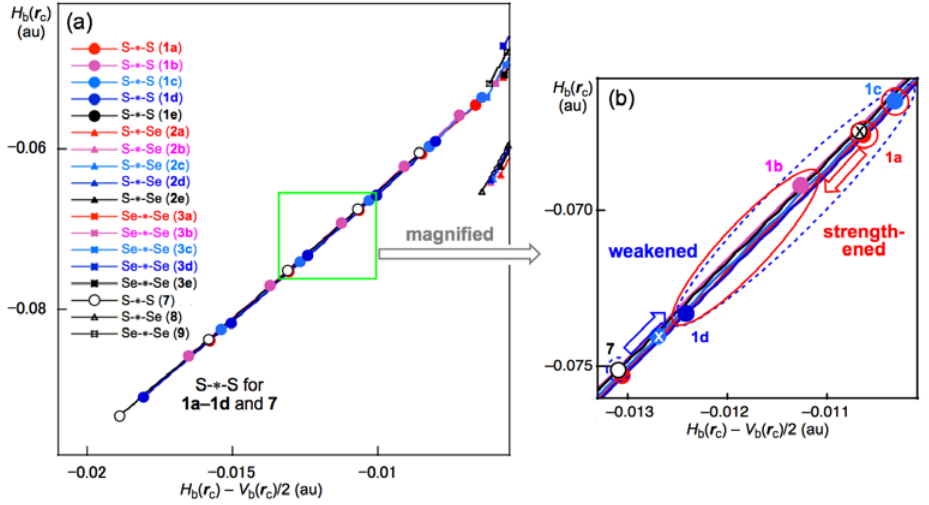
Figure 9. Plots of H b ( r c ) versus H b ( r c ) − V b ( r c )/2 for 1a – 1e and 7 . ( a ) Whole plot and ( b ) magnified view of the data around the fully optimized structures.